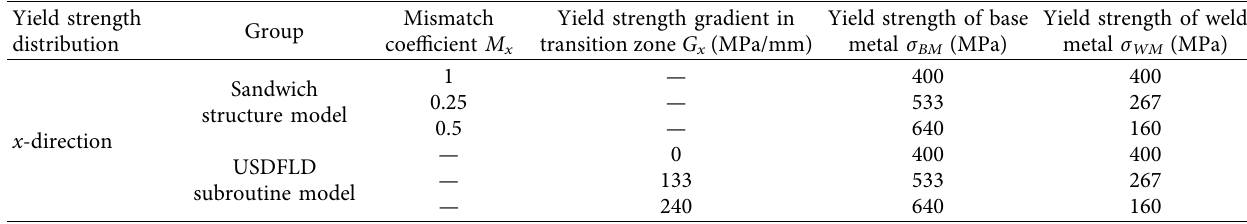
Table 1: Elastic-plastic material property with yield strength changing in the x -direction.